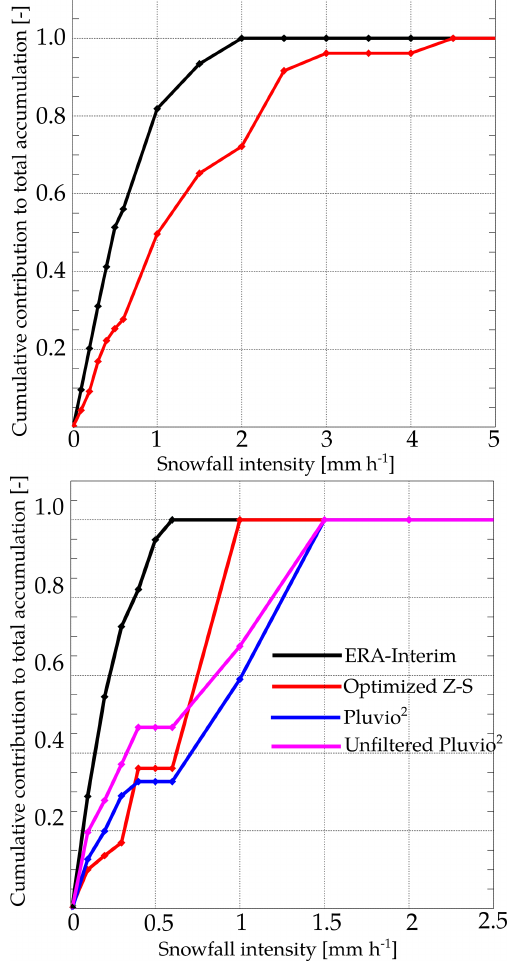
Figure 11. Cumulative contribution of increasing snowfall rates to the accumulated snowfall for the full year (top panel) and summer period (bottom panel). The timescale of snowfall intensity is also 6h for MRR and Pluvio 2 data, to be consistent with the temporal resolution of